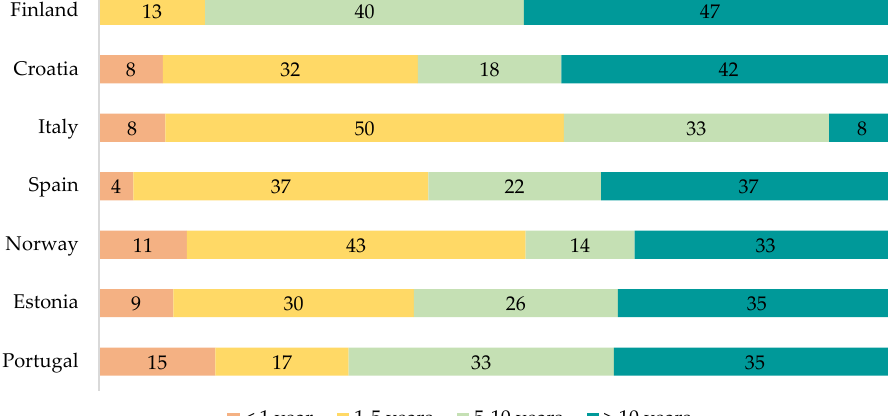
Figure 3. Relative distribution of time of activity by country (%).